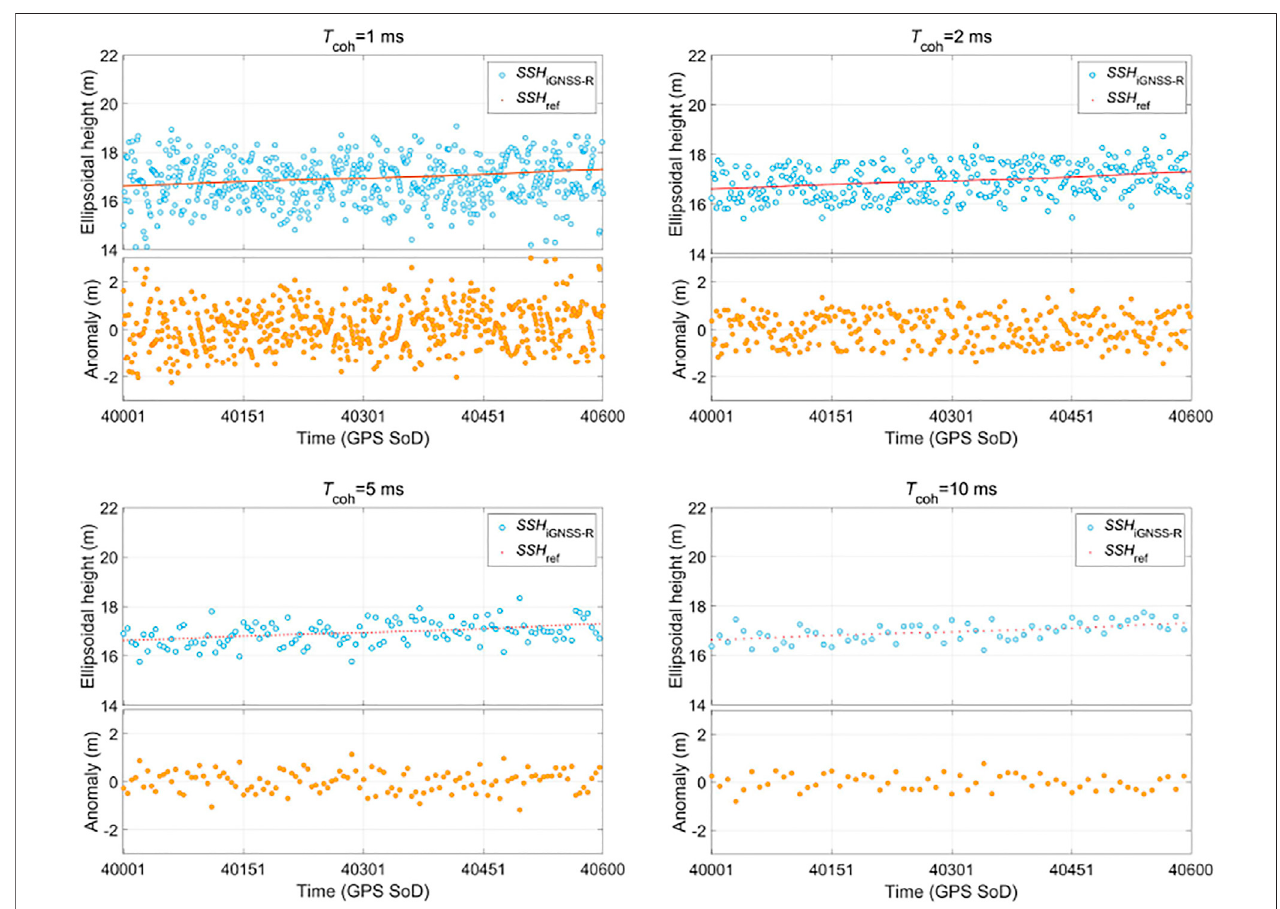
FIGURE 7 | Airborne iGNSS-R altimetric accuracy under different signal processing time.